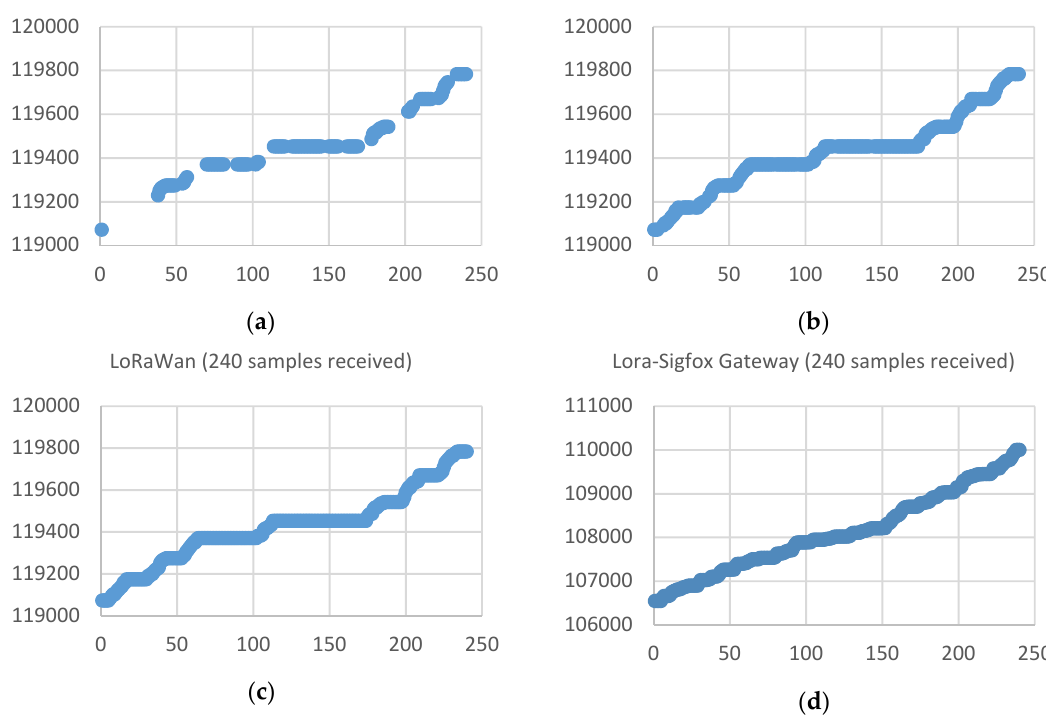
Figure 23. Number of samples received in the case of a building in which the reception rate is ranged within 25%-75%. ( a ) In the 169 MHz ISM band, 121 samples were received (50.4%). ( b ) Reception rate with the Sigfox prototype of 90.8% ( c ) Reception rate with the LoRaWan device of 100% ( d ) Reception rate with the LoRa-Sigfox Gateway device of 100%.